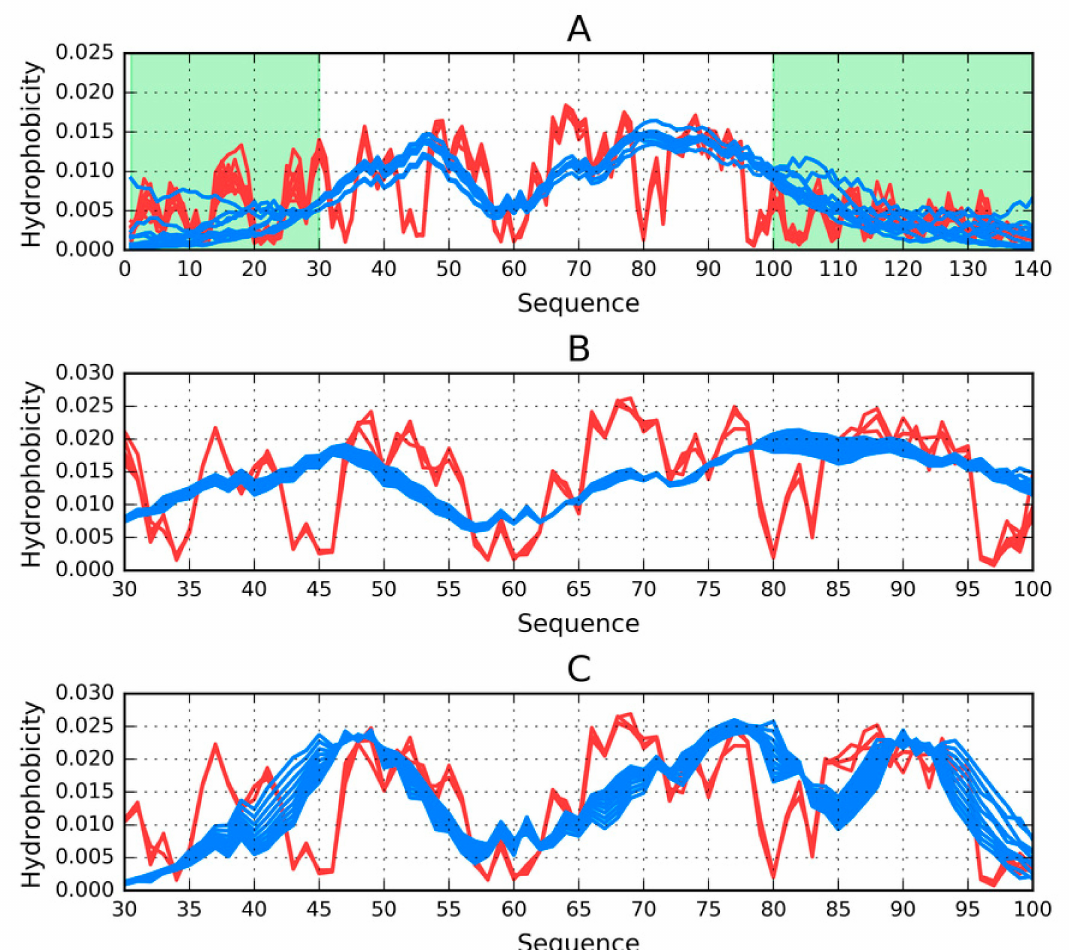
Figure 3. Theoretical (T, blue) and observed (O, red) hydrophobicity density distribution profiles for the ASyn amyloid (2N0A). Each chart shows two profiles for every chain from the complex (10 in total); ( A )—Calculations performed for the entire complex (1–140). Random coil fragments (1–29, 101–140) are highlighted in green; ( B )—Calculations performed for the amyloid fragment (30–100) treated as part of the complex; ( C )—Calculations performed for the amyloid fragment (30–100) treated as an individual